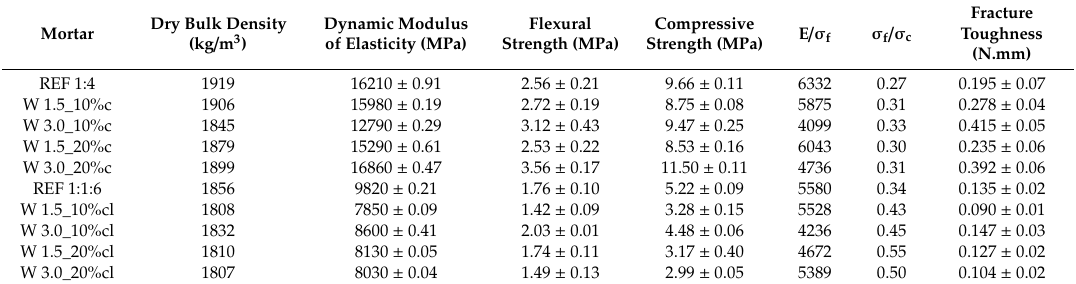
Table 6. The mechanical test results of the hardened mortars and parameters related to cracking. Dry Bulk Density Mortar (kg / m 3 )